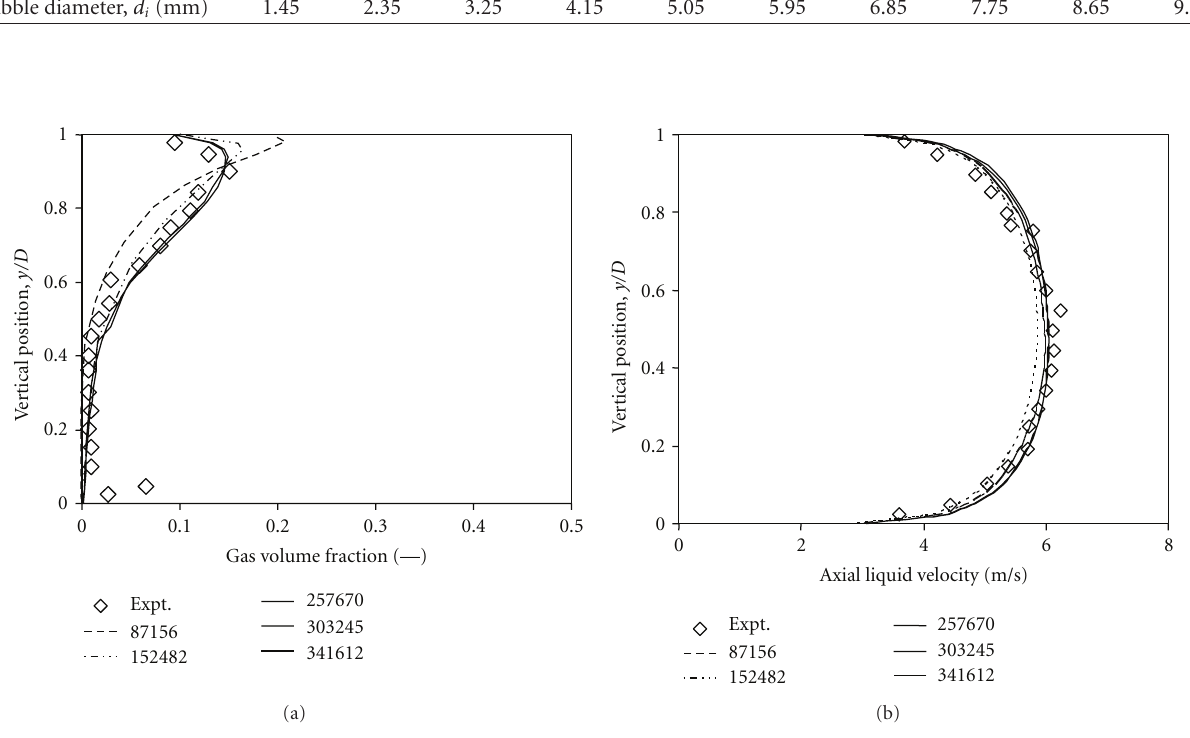
Figure 1: E ff ect of grid size on gas volume fraction and axial liquid